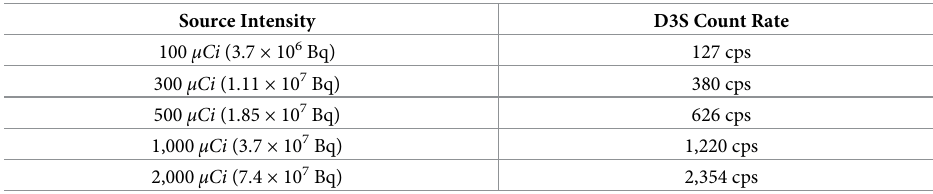
Table 1. Simulated source intensity in counts per